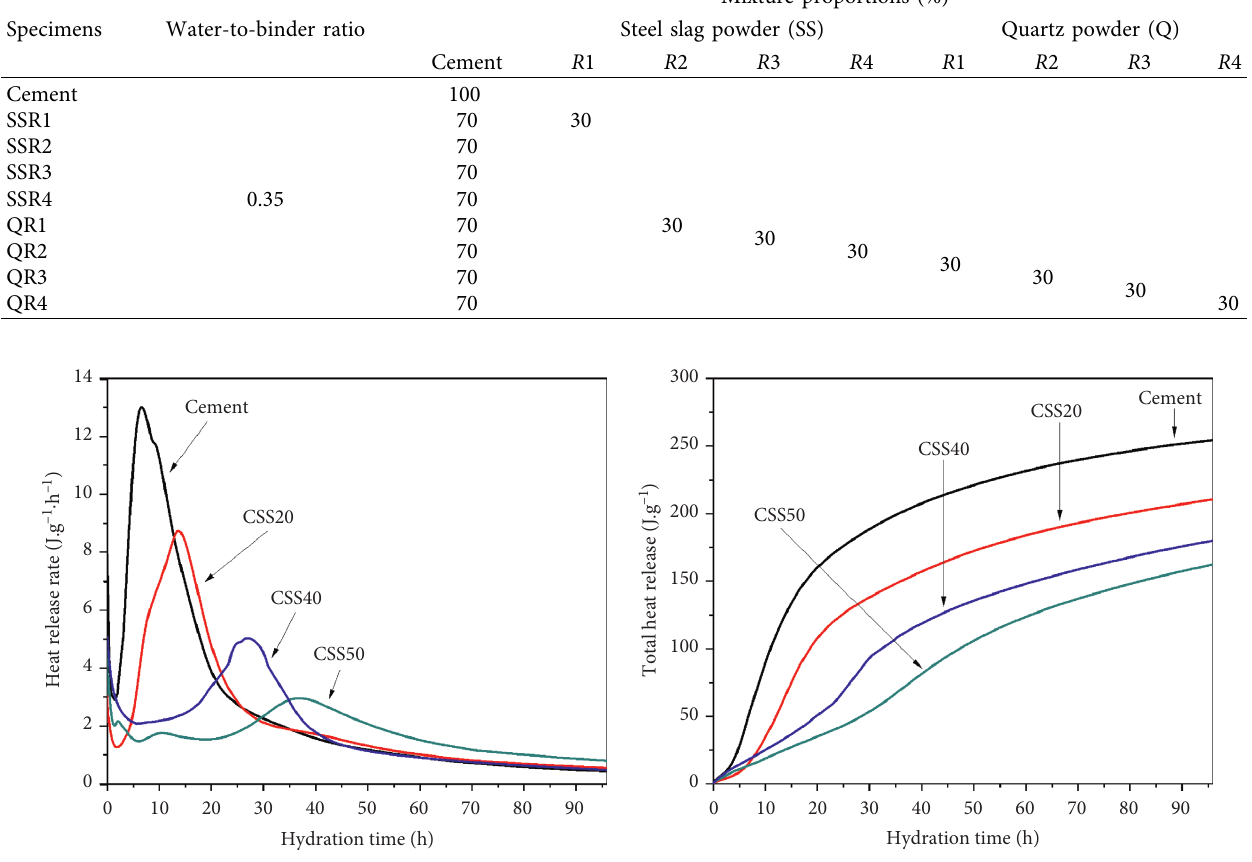
Figure 3: Hydration heat curves of blended cement containing different amounts of steel slag powder. (a) Exothermic rate. (b) Total heat release.